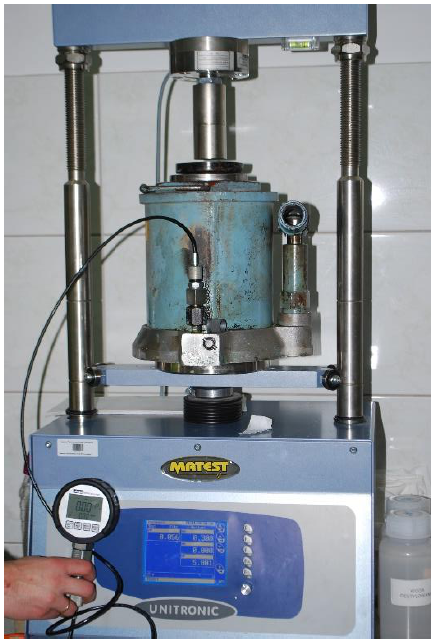
Figure 7. View of the correlation test of the manometer indications against the value of force exerted.